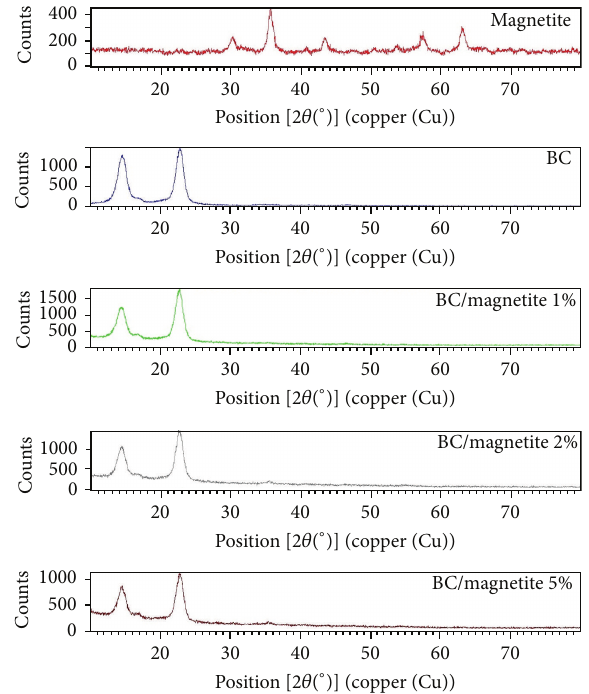
Figure 2: XRD diffractograms of pure BC, magnetite, and BC/ magnetite